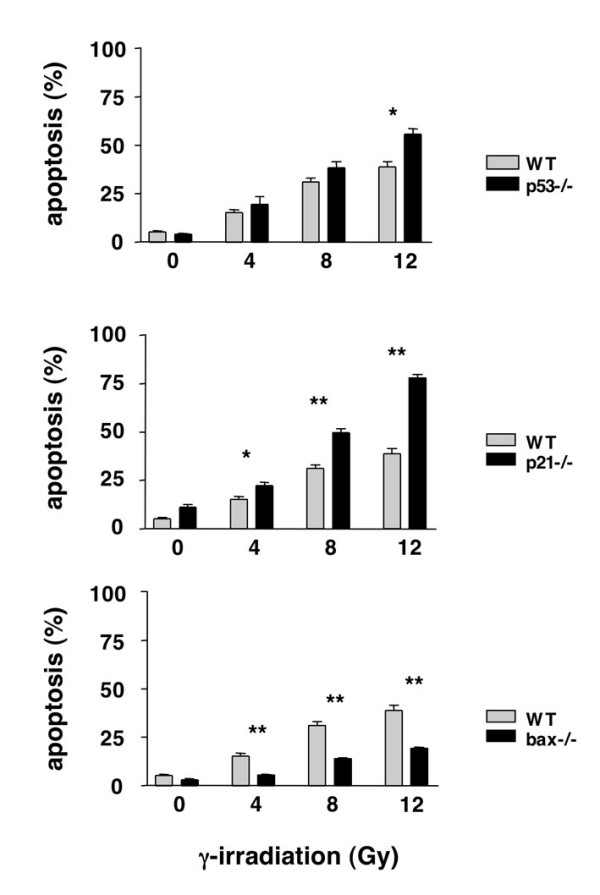
Induction of apoptosis by γ-radiation. HCT116 cells were exposed to IR and cultured for 72 h. Grey bars: wild type. Black bars: knock-out mutants. Upper panel p53-/-, middle panel p21CIP/WAF-1-/-, lower panel Bax -/-. *: p < 0.05, **: p < 0.005.